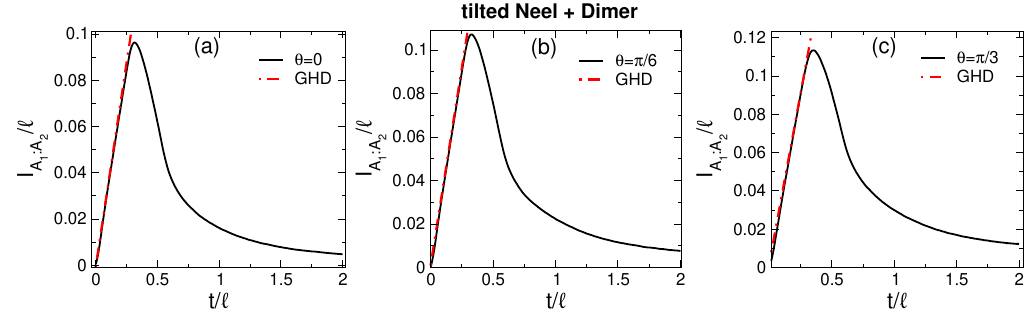
Figure 10: Dynamics of the mutual information between two intervals after the quench from the state | Néel, θ 〉 ⊗ | dimer 〉 in the XXZ chain with ∆ = 2. Here we show the mutual information between two adjacent intervals next to the interface between the two chains. The data are for two intervals with (cid:96) = 100 embedded in a chain with . The different panels are for different tilting angles θ . The dash-dotted lines are the GHD predictions for the slope of the linear growth at short times. No- tice that the slope depends on the macrostate with ζ = 0 that describes the interface between the two